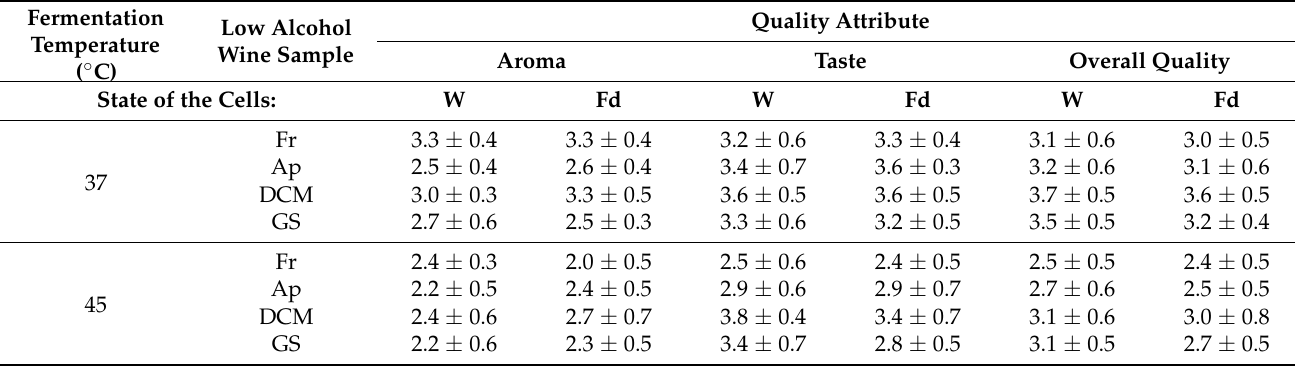
Table 5. Sensory evaluation of semi-dry and sweet low alcohol wines produced by wet and freeze-dried kefir culture at high temperatures (37 and 45 ◦